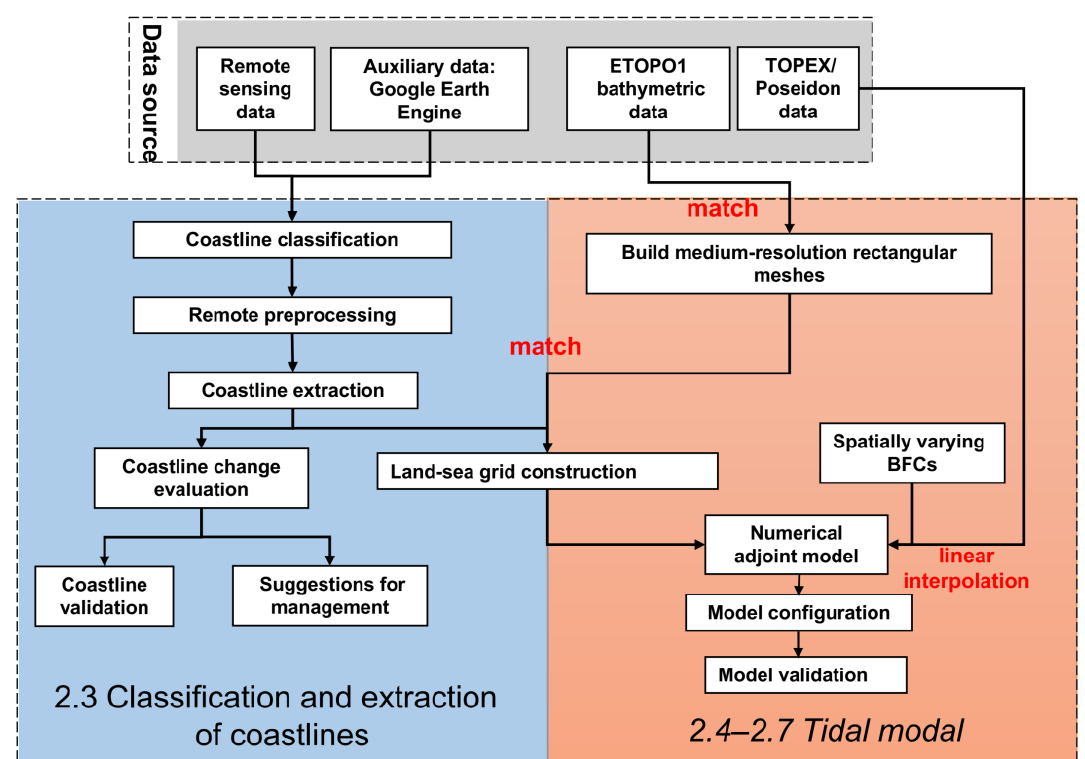
Figure 2. Technological framework of this